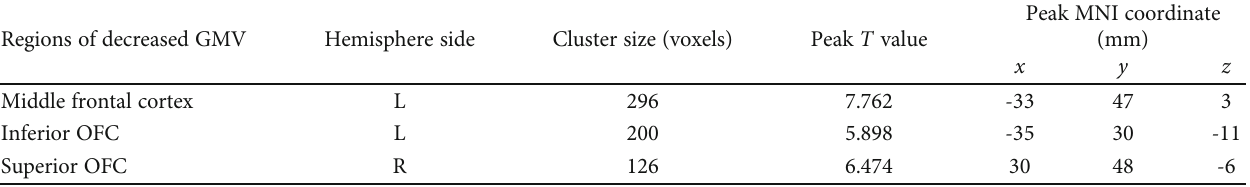
Table 3: Regions showing signi fi cantly decreased grey matter volume (GMV) in spinal cord injury (SCI) patients. Regions of decreased GMV